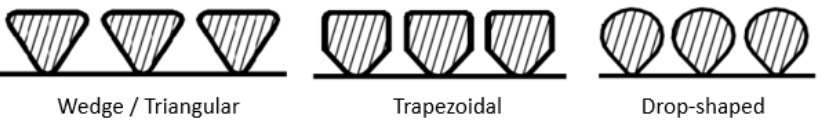
Figure 2. Different wire profiles [by